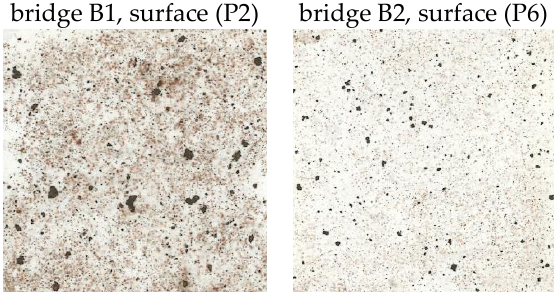
Figure 13. Scotch-tape tests on selected horizontal surfaces.